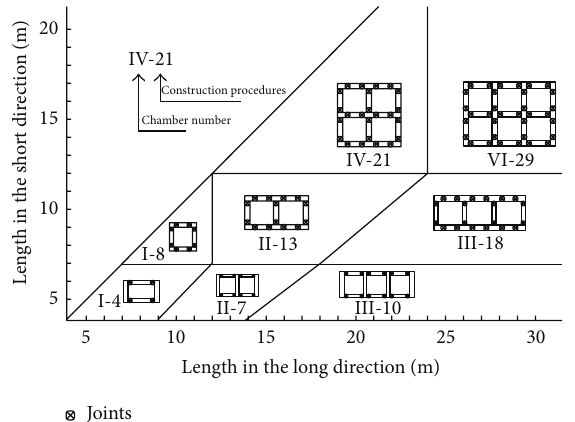
Figure 3: Construction procedures and joint arrangement for